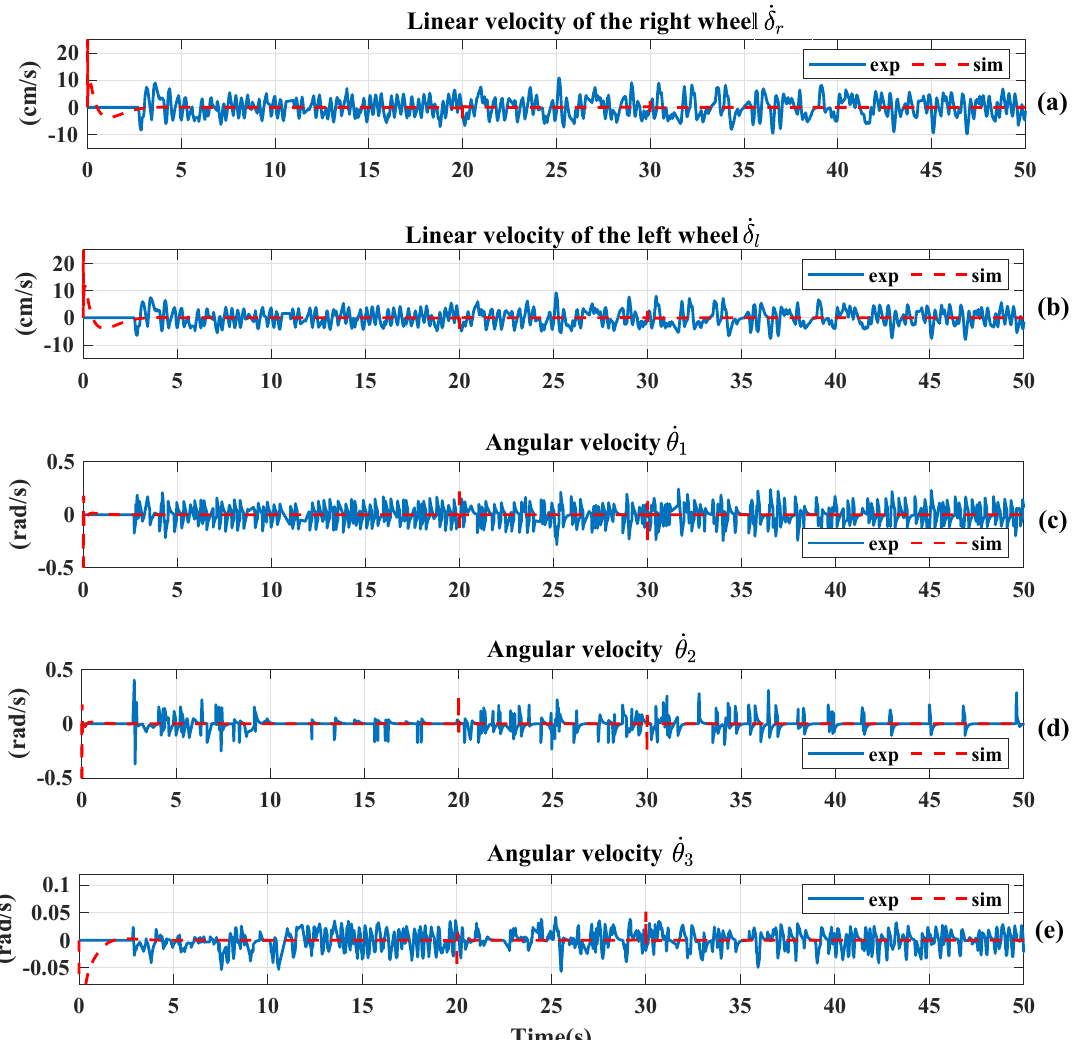
Figure 9. Response of velocities states: ( a ) Linear velocity of the right wheel ˙ δ r , ( b ) linear velocity of the left wheel ˙ δ l , ( c ) angular velocity of the first link ˙ θ 1 , ( d ) angular velocity of the second link ˙ θ 2 , and ( e ) angular velocity of the third link ˙ θ 3